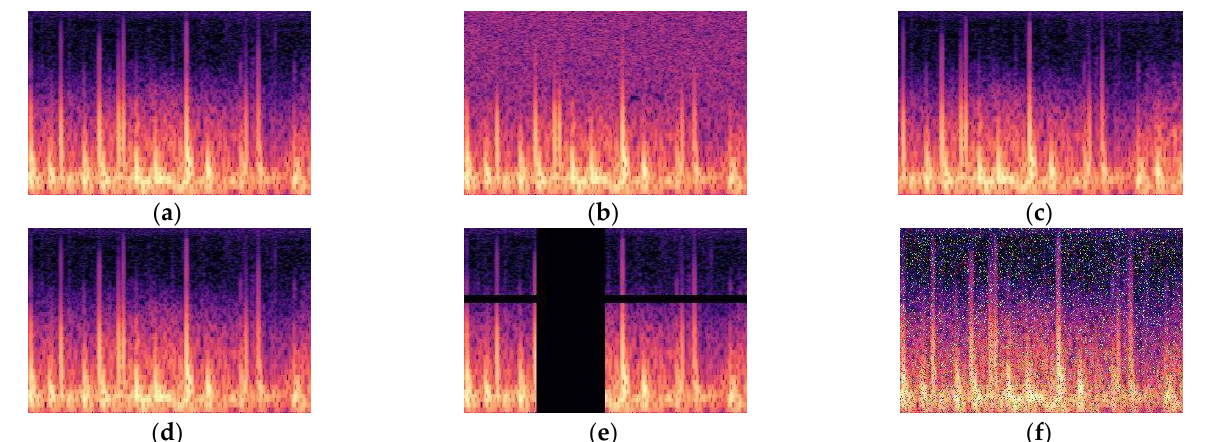
Figure 6. ( a ) Normal heartbeat spectrogram and ( b ) abnormal heartbeat spectrogram.